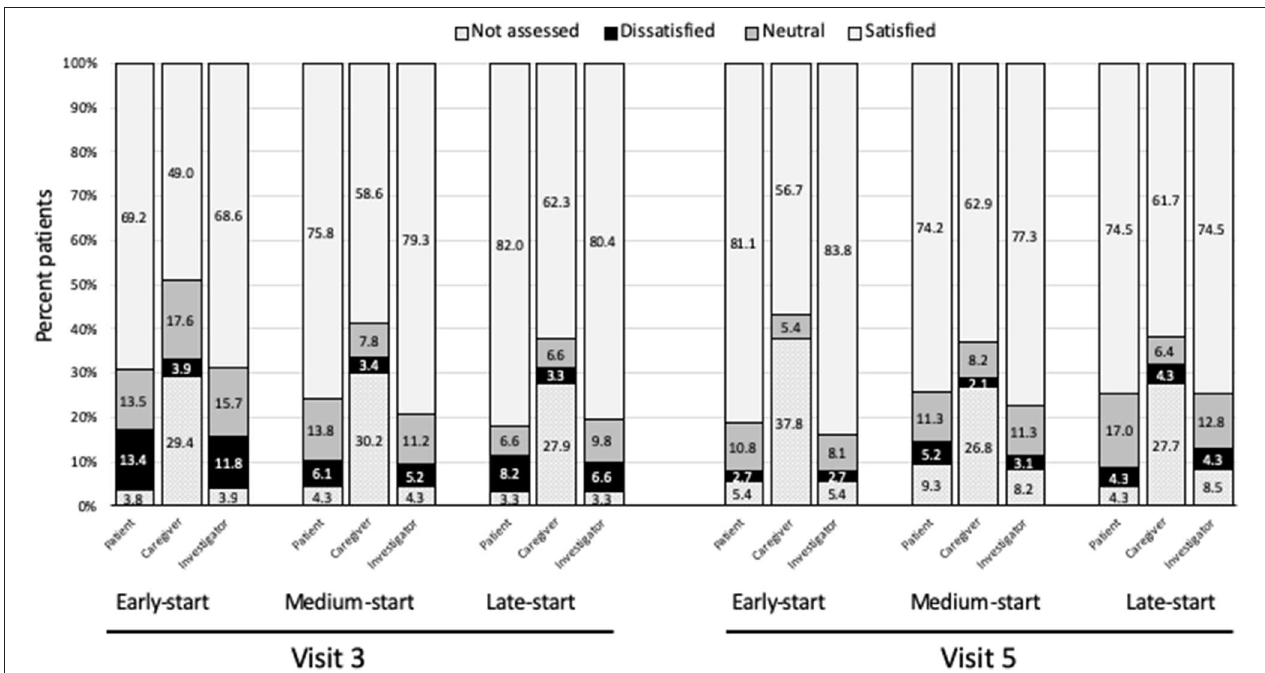
FIGURE 4 | Satisfaction with treatment. Study visits were at end of treatment cycle. Satisfied = satisfied + very satisfied; Dissatisfied = unsatisfied + very